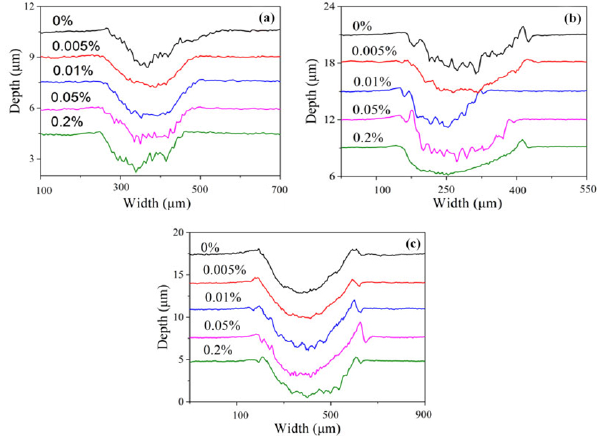
Fig. 6 Wear profiles of the lower disk lubricated by PAO6 containing or without TiL 4 /BP nanocomposites under different loads: (a) 8 N, (b) 20 N, and (c) 30 N.